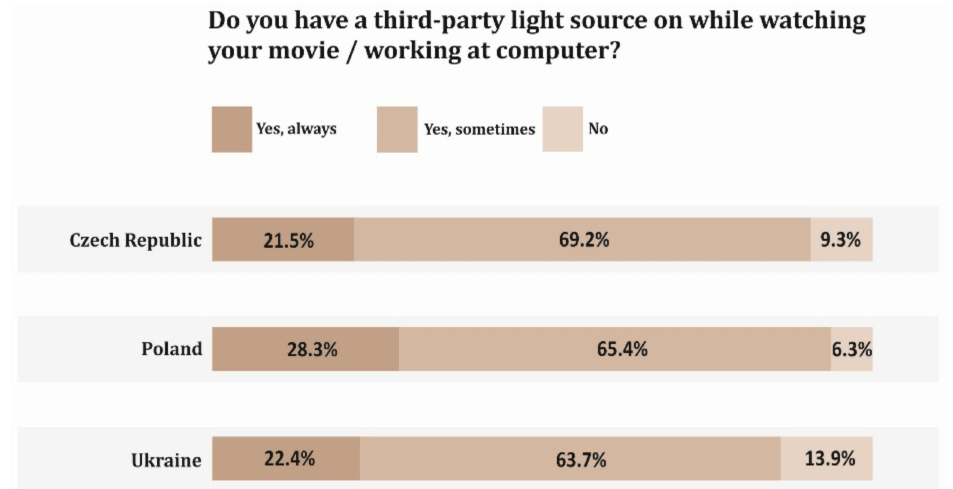
Figure 9. Distribution of answers to the question on the use of additional artificial lighting while working at a computer or watching TV. Source: own